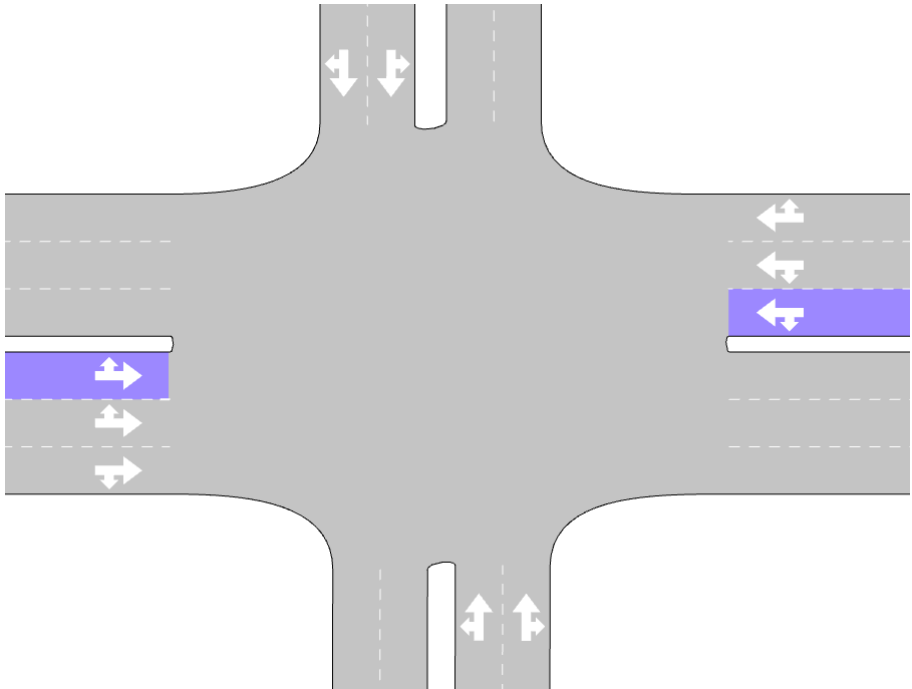
Figure 7. An enlarged version of the 1-Intersection model, representing an interrupted urban setting with a detector spanning one whole lane